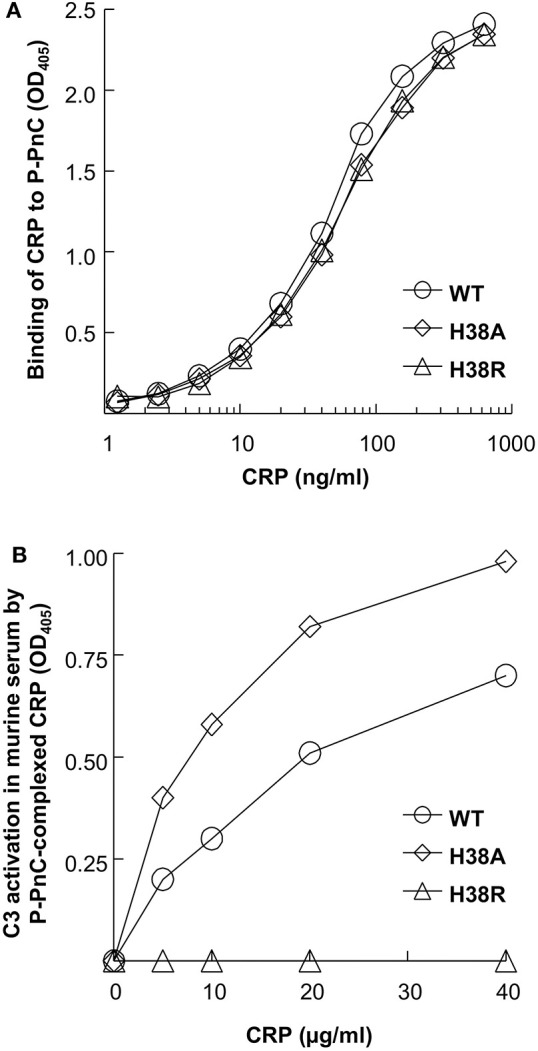
Activation of murine complement by human CRP. A representative of three experiments is shown. (A) Binding of CRP to P-PnC. Microtiter wells were coated with P-PnC. CRP diluted in TBS-Ca was added to the wells. Bound CRP was detected by using an anti-CRP antibody. Color was developed and the OD was read at 405 nm. (B) Activation of murine C3 by CRP complexed with P-PnC. Microtiter wells were coated with P-PnC. CRP diluted in TBS-Ca was added to the wells. Normal mouse serum was then added to the wells. Deposited C3 was detected by using goat anti-mouse C3 antibody. Color was developed and the OD was read at 405 nm.